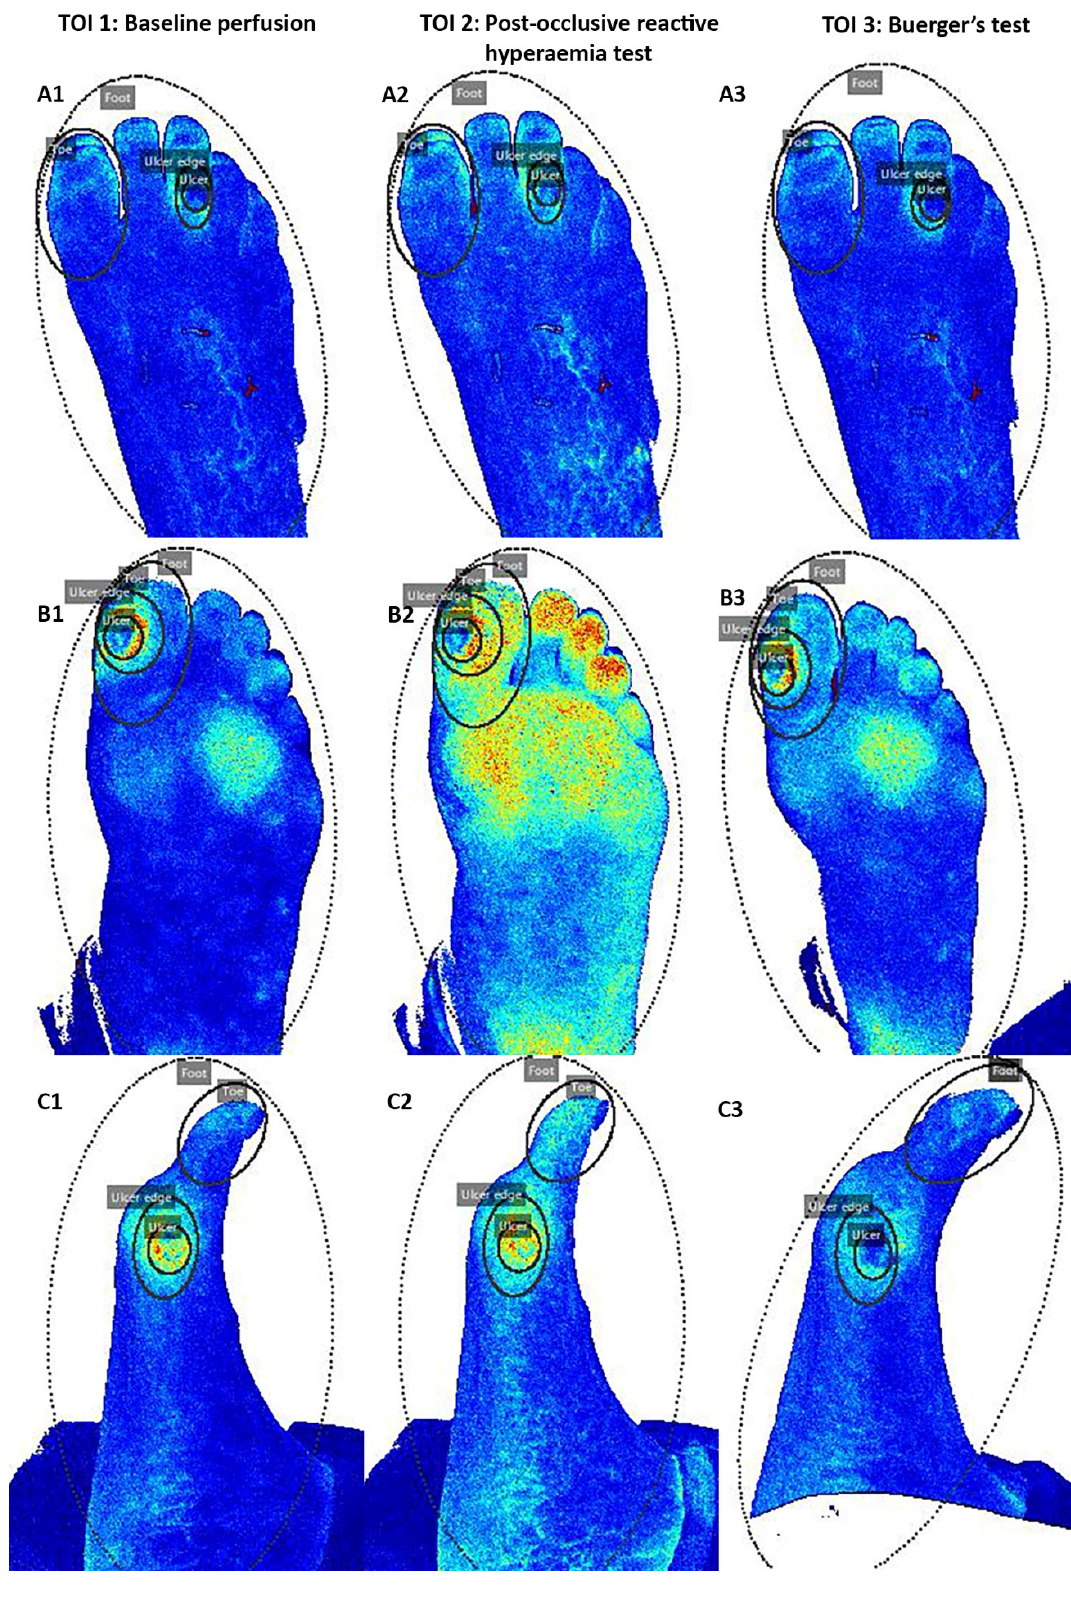
Figure 7. ROI tracking during baseline measurement ( left ), Post-Occlusive Reactive Hyperaemia Test ( middle ), and Buerger’s test ( right ) for three different patients ( A (plantar view), B (plantar view), C (medial view)). The ROI during Buerger’s test was manually repositioned for the first frame of the